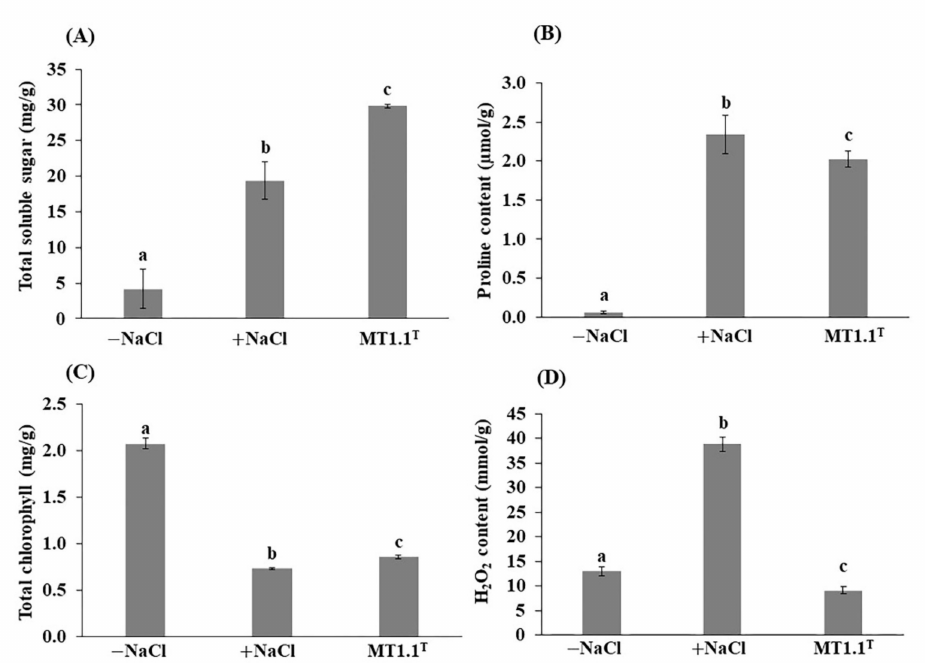
Figure 2. Effect of D. abyssi MT1.1 T on biochemical parameters of tomato seedlings under 150 mM NaCl. ( A ) total soluble sugar, ( B ) proline content, ( C ) total chlorophyll content, and ( D ) hydrogen peroxide content. Data represent the mean values of three replicates. Different letters (a, b, and c) indicate a significant difference according to Duncan at p <